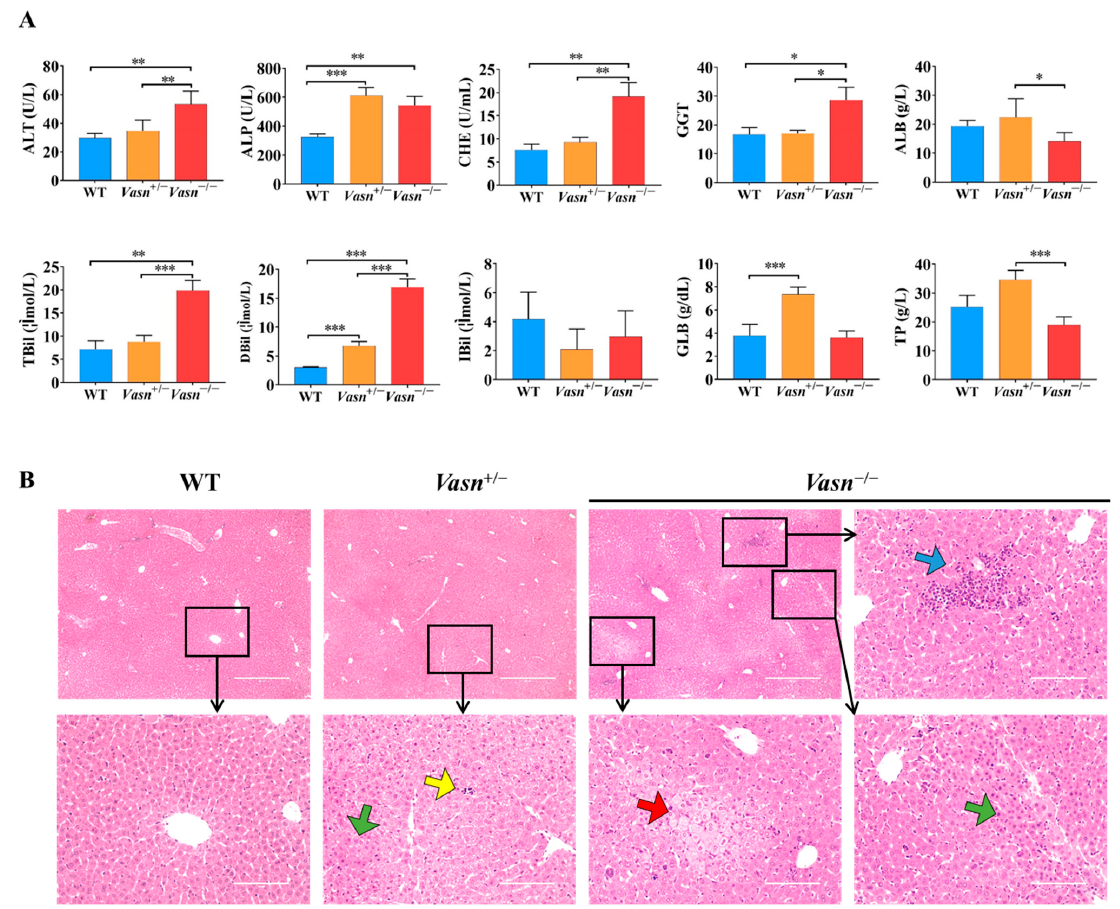
Figure 2. Liver injury induced in Vasn − / − and Vasn +/ − . ( A ) Serum liver function tests suggest that liver injury was induced in Vasn − / − and Vasn +/ − mice. * p < 0.05, ** p < 0.01, *** p < 0.001. ( B ) H&E staining of liver from Vasn − / − , Vasn +/ − , and WT mice at 3 weeks of age; yellow arrows show spotty necrosis, green arrows show inflammation, blue arrows show slice necrosis, and red arrows show ballooning degeneration. Data are expressed as mean ± SD of three independent experiments. * p < 0.05, ** p < 0.01, *** p < 0.001.